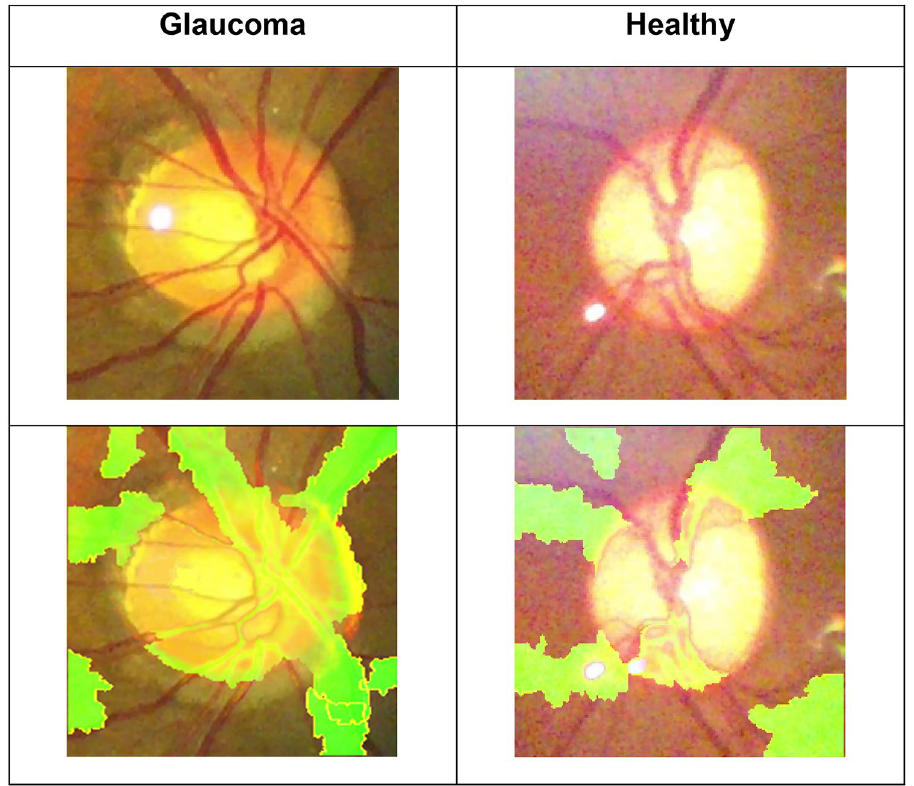
Figure 8. Average intensity map (60 sequential frames) from the LIME algorithm applied to the combined models showing significant regions of the image used to predict glaucoma and healthy. Regions with brighter intensity (green) indicate a larger impact compared to regions with lower intensity